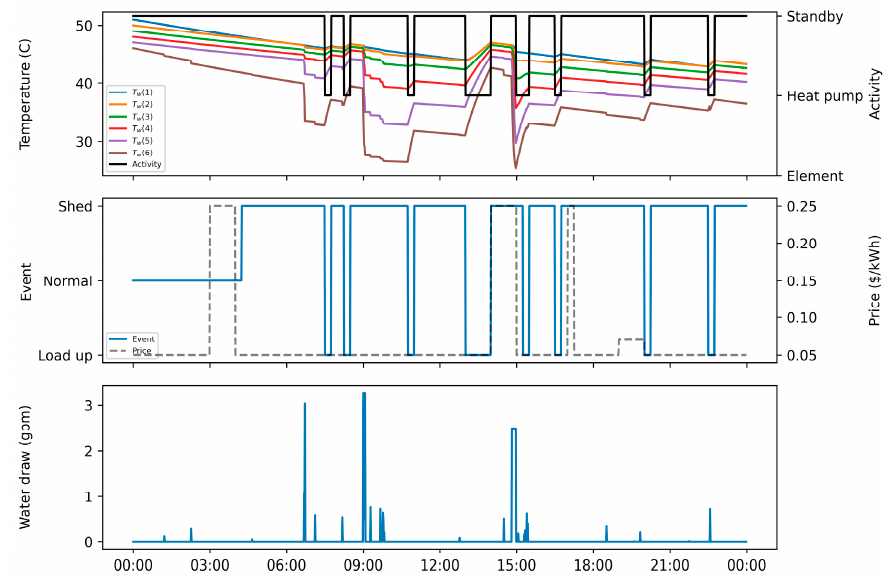
Figure 10. Operation based on MPC #4.